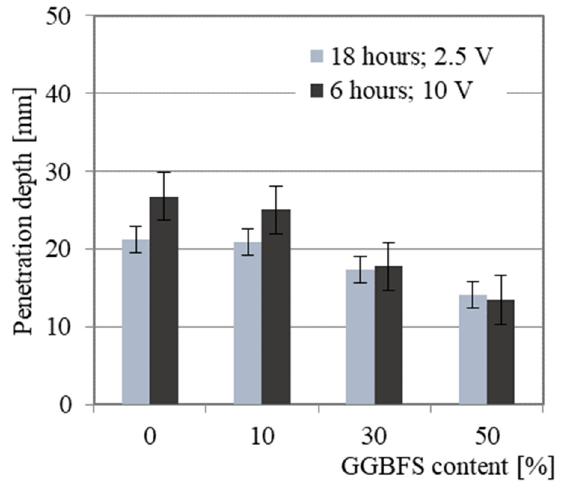
Figure 10. The average chloride penetration depths with reference to GGBFS content.